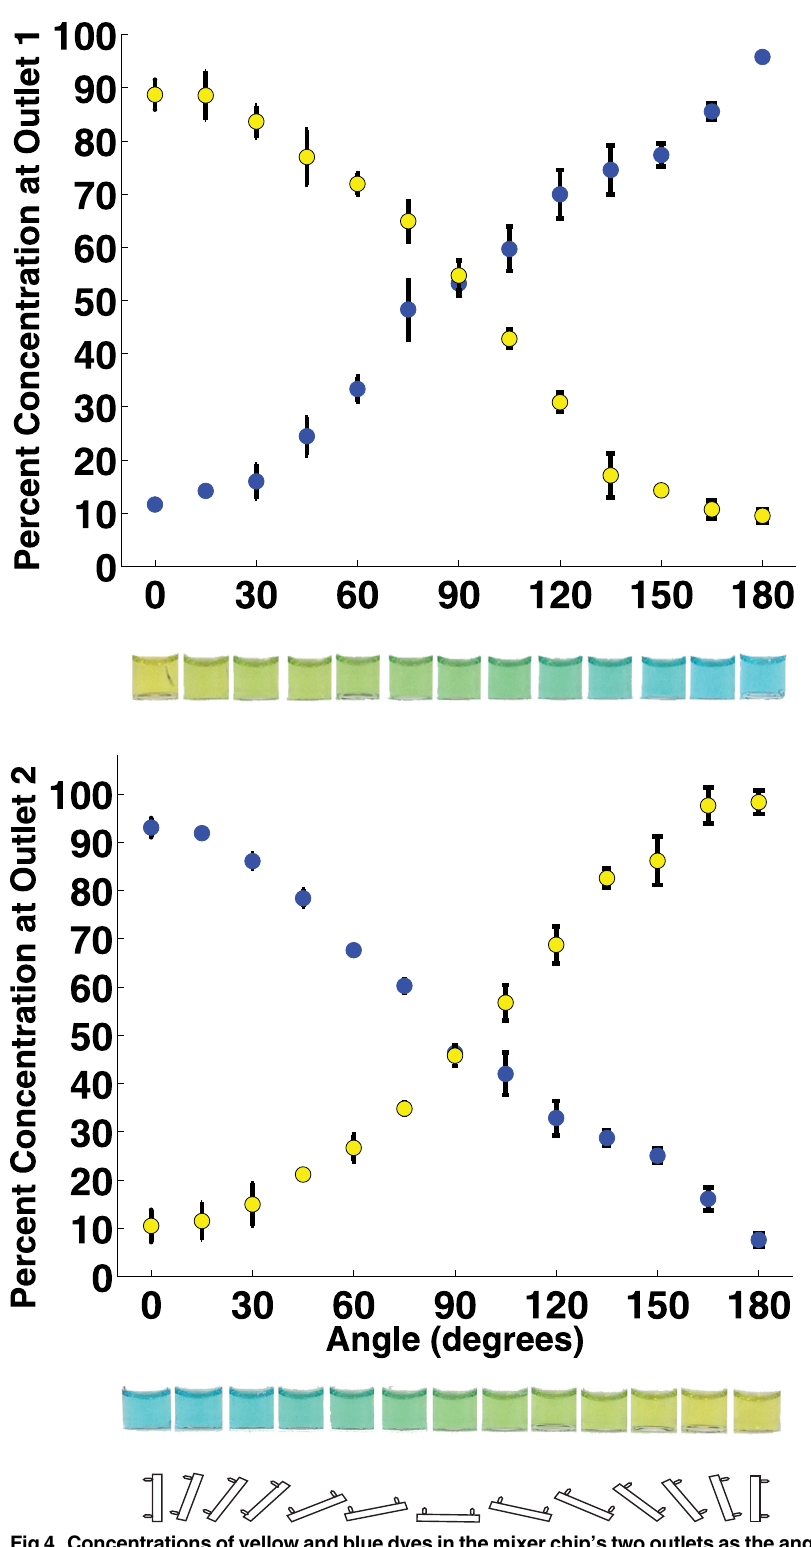
Fig 4. Concentrations of yellow and blue dyes in the mixer chip ’ s two outlets as the angle of rotation of the mixer chip is varied from 0° to 180°. Also shown are photographs of the fluid collected at each outlet and an illustration of the chip ’ s orientation at each angle of rotation. N = 3 measurements for each point;